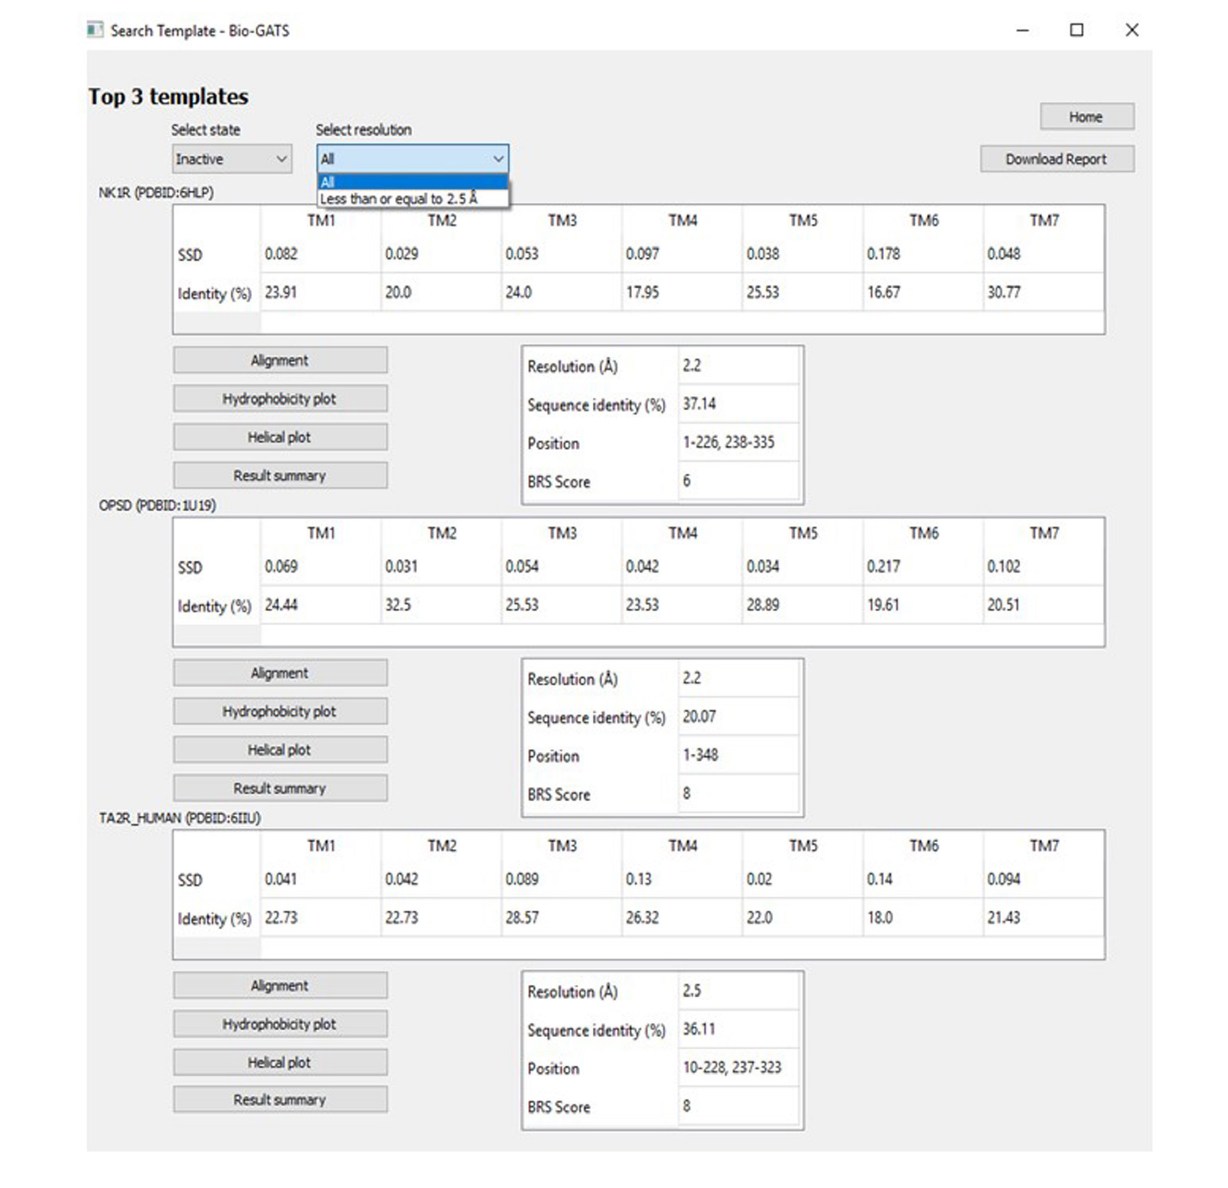
FIGURE 7 | The Search template window with options including GPCR conformation (state) and